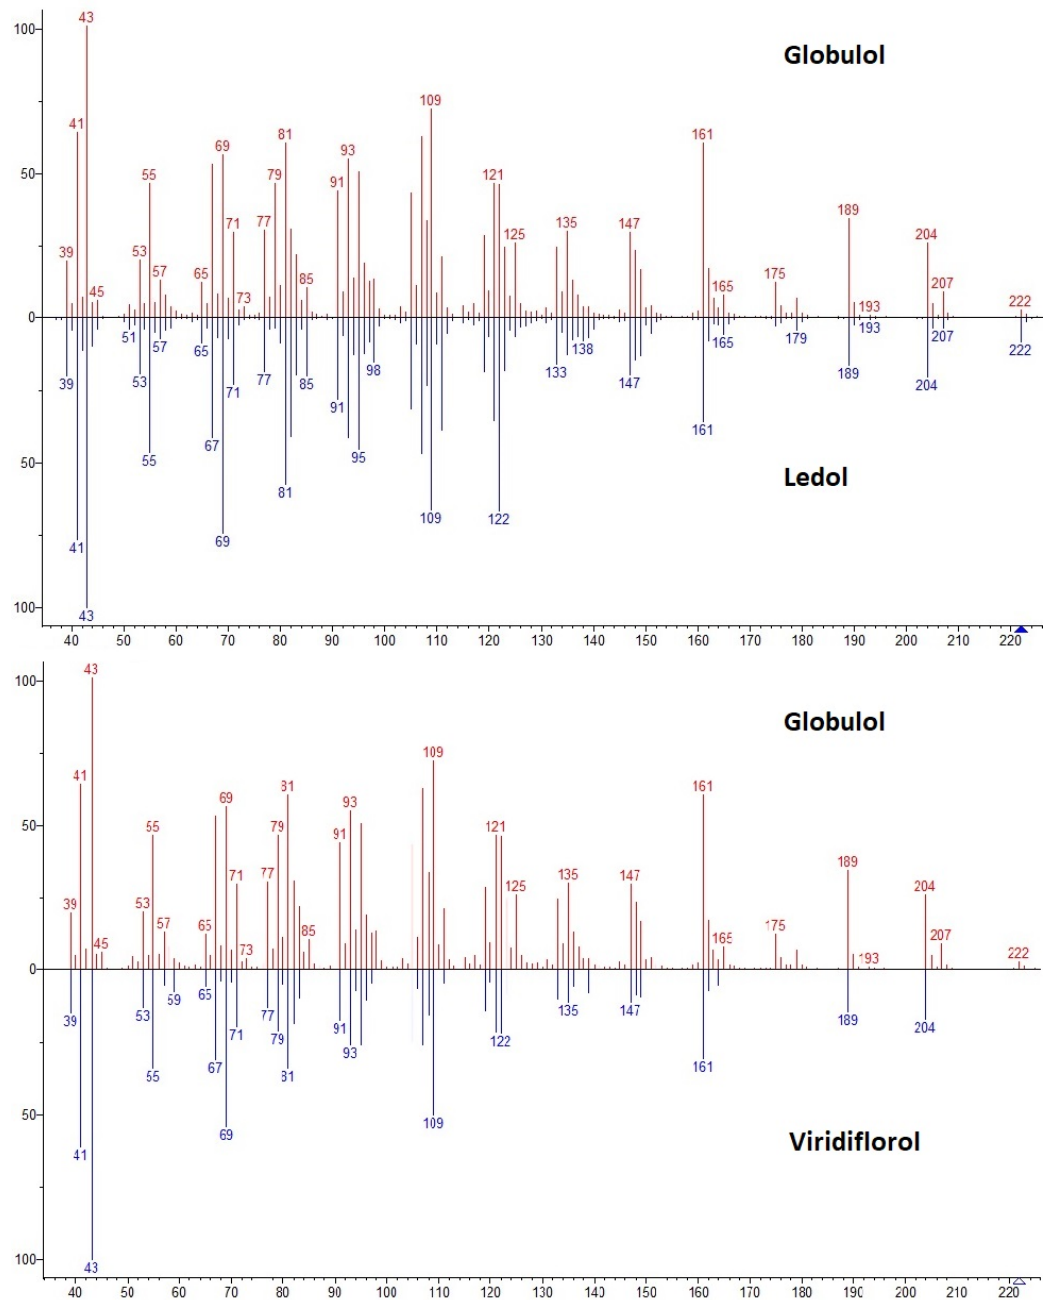
Figure 18. Examples of two different mirror matches between globulol and ledol (upper panel) and globulol and viridiflorol (lower panel).